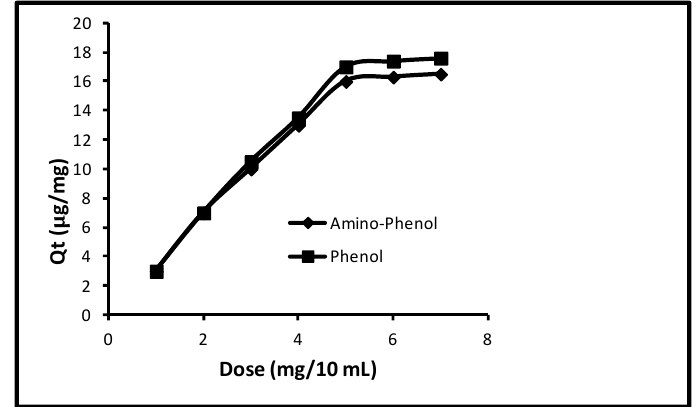
Figure 5. Effect of amount of nanoparticles enclosed in the membrane cone.